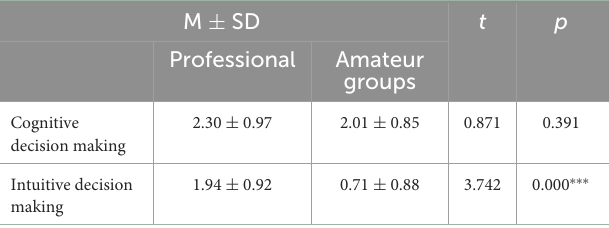
TABLE 3 Average accuracy of the two groups of subjects in different types of decision-making tasks (unit: percentage). M ±